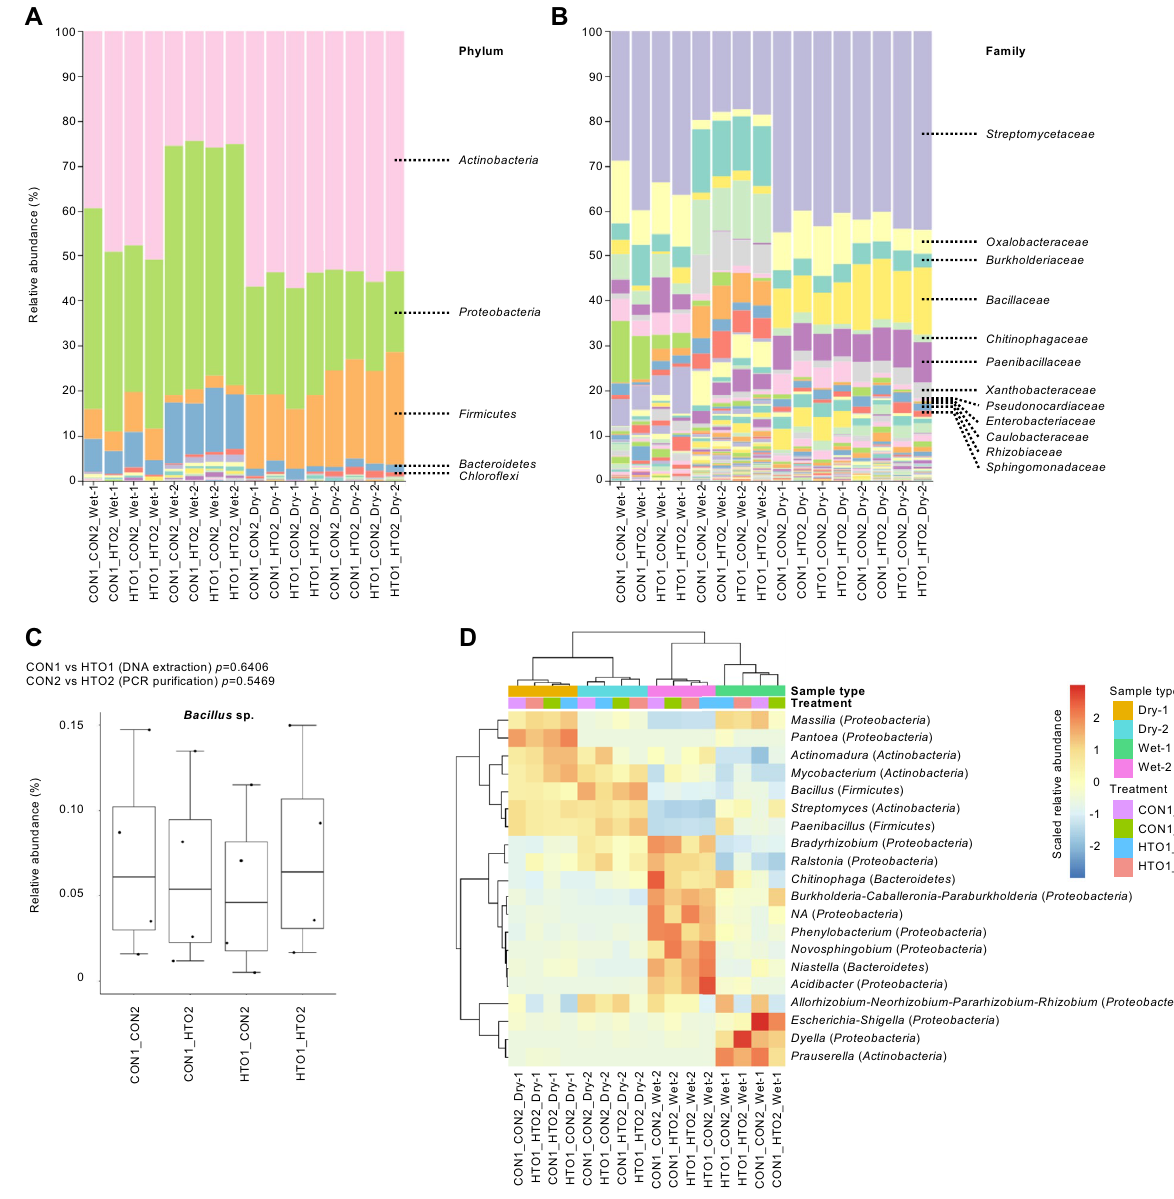
Figure 4. Taxonomic profile of plant root microbiome among different methods. The relative abundances of major phyla ( A ), family ( B ), and gram-positive Bacillus sp. ( C ) are shown. ( D ) Hierarchical clustering heat map based on the relative abundance of the 20 most abundant ASVs. The heat map was visualized using pheatmap version 1.0.12 (https:// cran.r- proje ct. org/ web/ packa ges/ pheat map/ index.